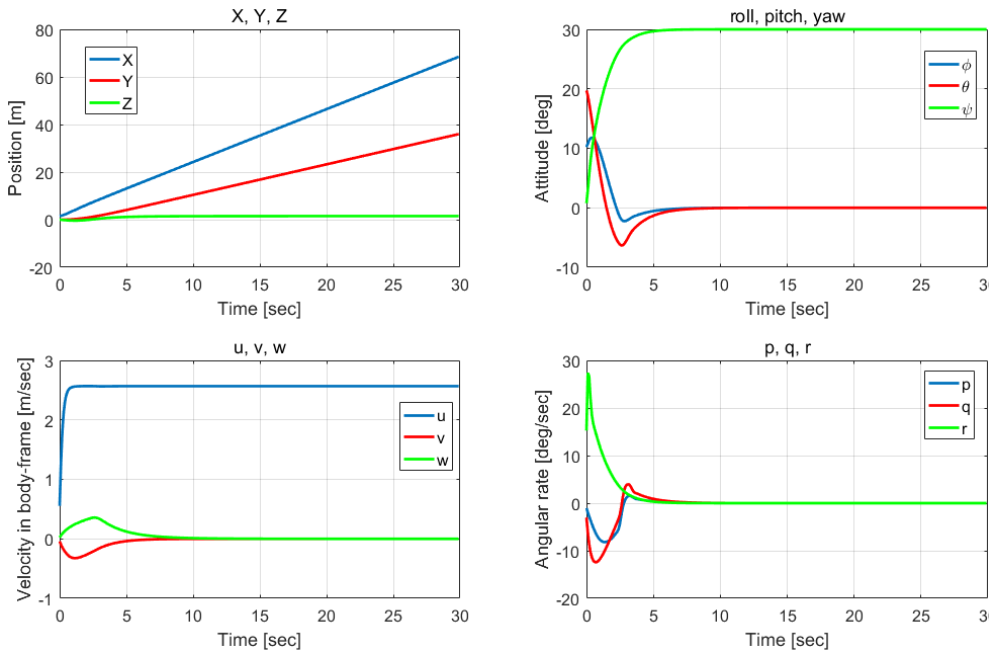
Figure 8. Vehicle’s motion information in the maximum speed